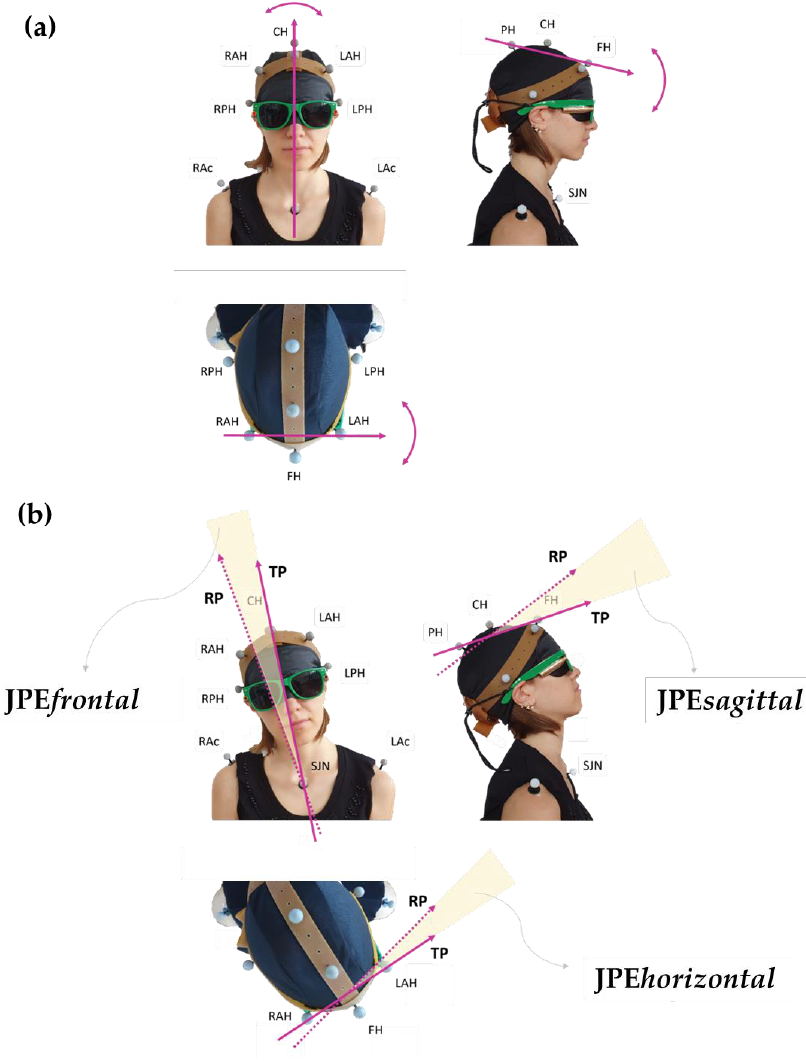
Figure 3. Panel ( a ) shows the vectors chosen to assess the head’s positions in the three classic anatomical orthogonal planes: 𝑹𝑨𝑯; 𝑳𝑨𝑯⃗⃗⃗⃗⃗⃗⃗⃗⃗⃗⃗⃗⃗⃗⃗⃗⃗⃗⃗⃗⃗⃗ allows evaluation of the rotation movements in the horizontal plane, 𝑷𝑯;𝑭𝑯⃗⃗⃗⃗⃗⃗⃗⃗⃗⃗⃗⃗⃗⃗⃗⃗ for flexion-extension movements in the sagittal plane, and 𝑺𝑱𝑵;𝑪𝑯 ⃗⃗⃗⃗⃗⃗⃗⃗⃗⃗⃗⃗⃗⃗⃗⃗⃗⃗ for side-bending movements in the frontal plane. Panel ( b ) provides a graphical visualisation of the planar JPEs calculated with respect to each plane: TP and RP refer to the vector “fixed” in its coordinates at the Target Position (TP; the one set by the operator during the assisted movement) and at the Reached Position (RP; the one attained during the actively performed movement), respectively. In this representation, examples of movements are shown separately in the frontal, sagittal, and horizontal views. Subject’s spatial orientation as in Figure